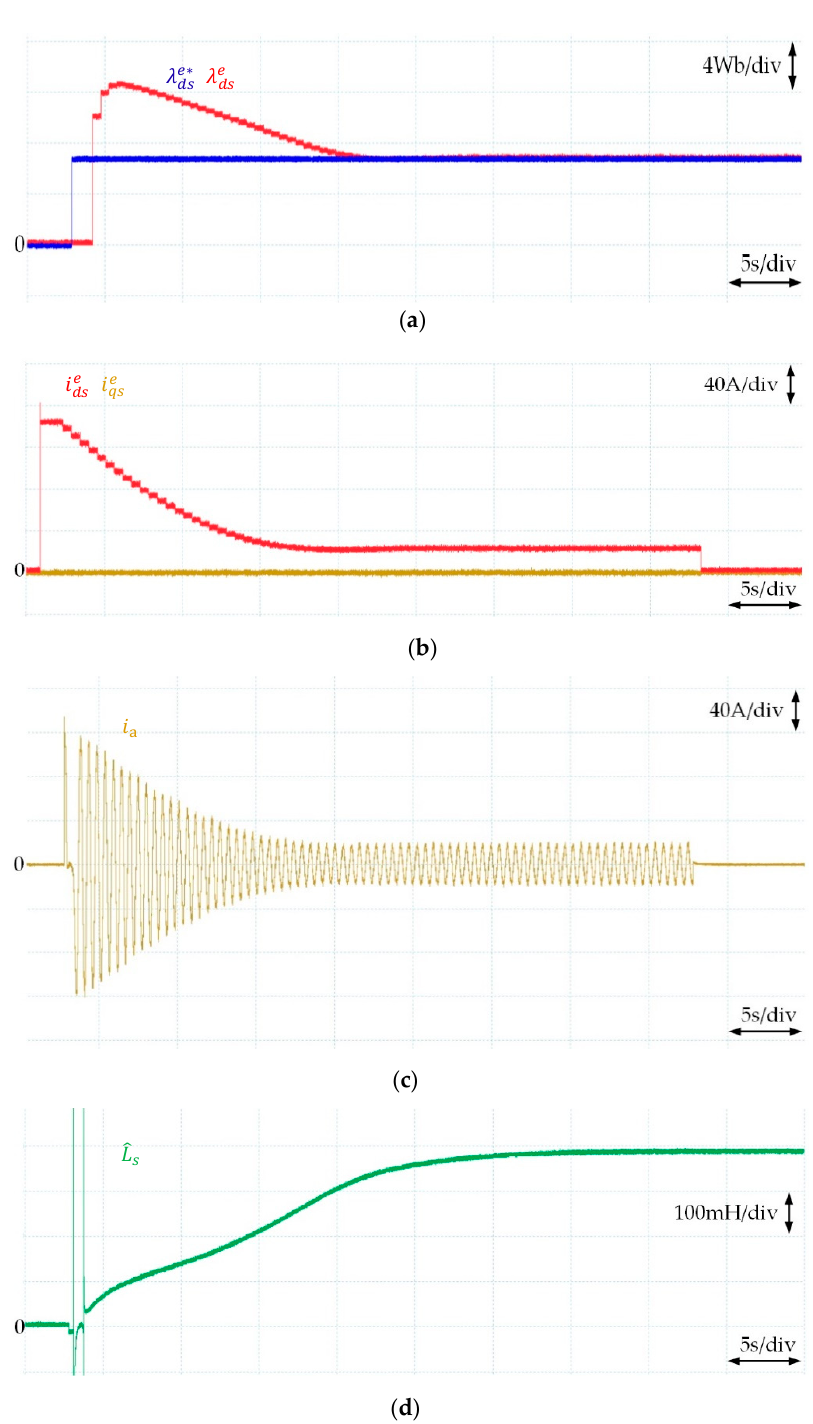
Figure 13. Experimental results for the third motor (560 kW/3300 V); ( a ) reference and estimated stator flux, ( b ) dq -axis reference and measured currents in a rotating reference frame, ( c ) a-phase current, ( d ) identified stator inductance.